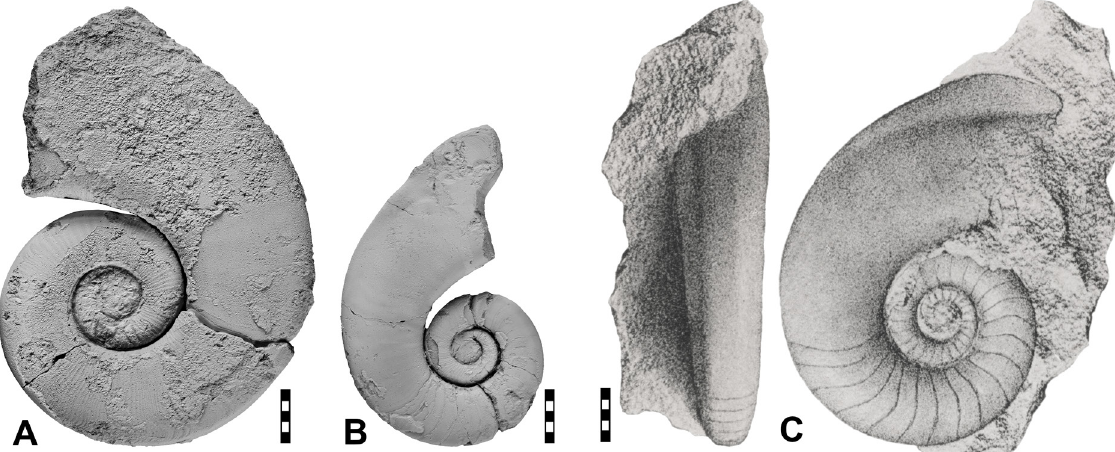
Fig. 73. Cyclolituites lynceus Holm, 1891. A . Specimen MB.C.30561 (Neben & Krueger Coll.) from Oderberg (Brandenburg). B . Specimen MB.C.30562 (Neben & Krueger 1962 Coll.) from